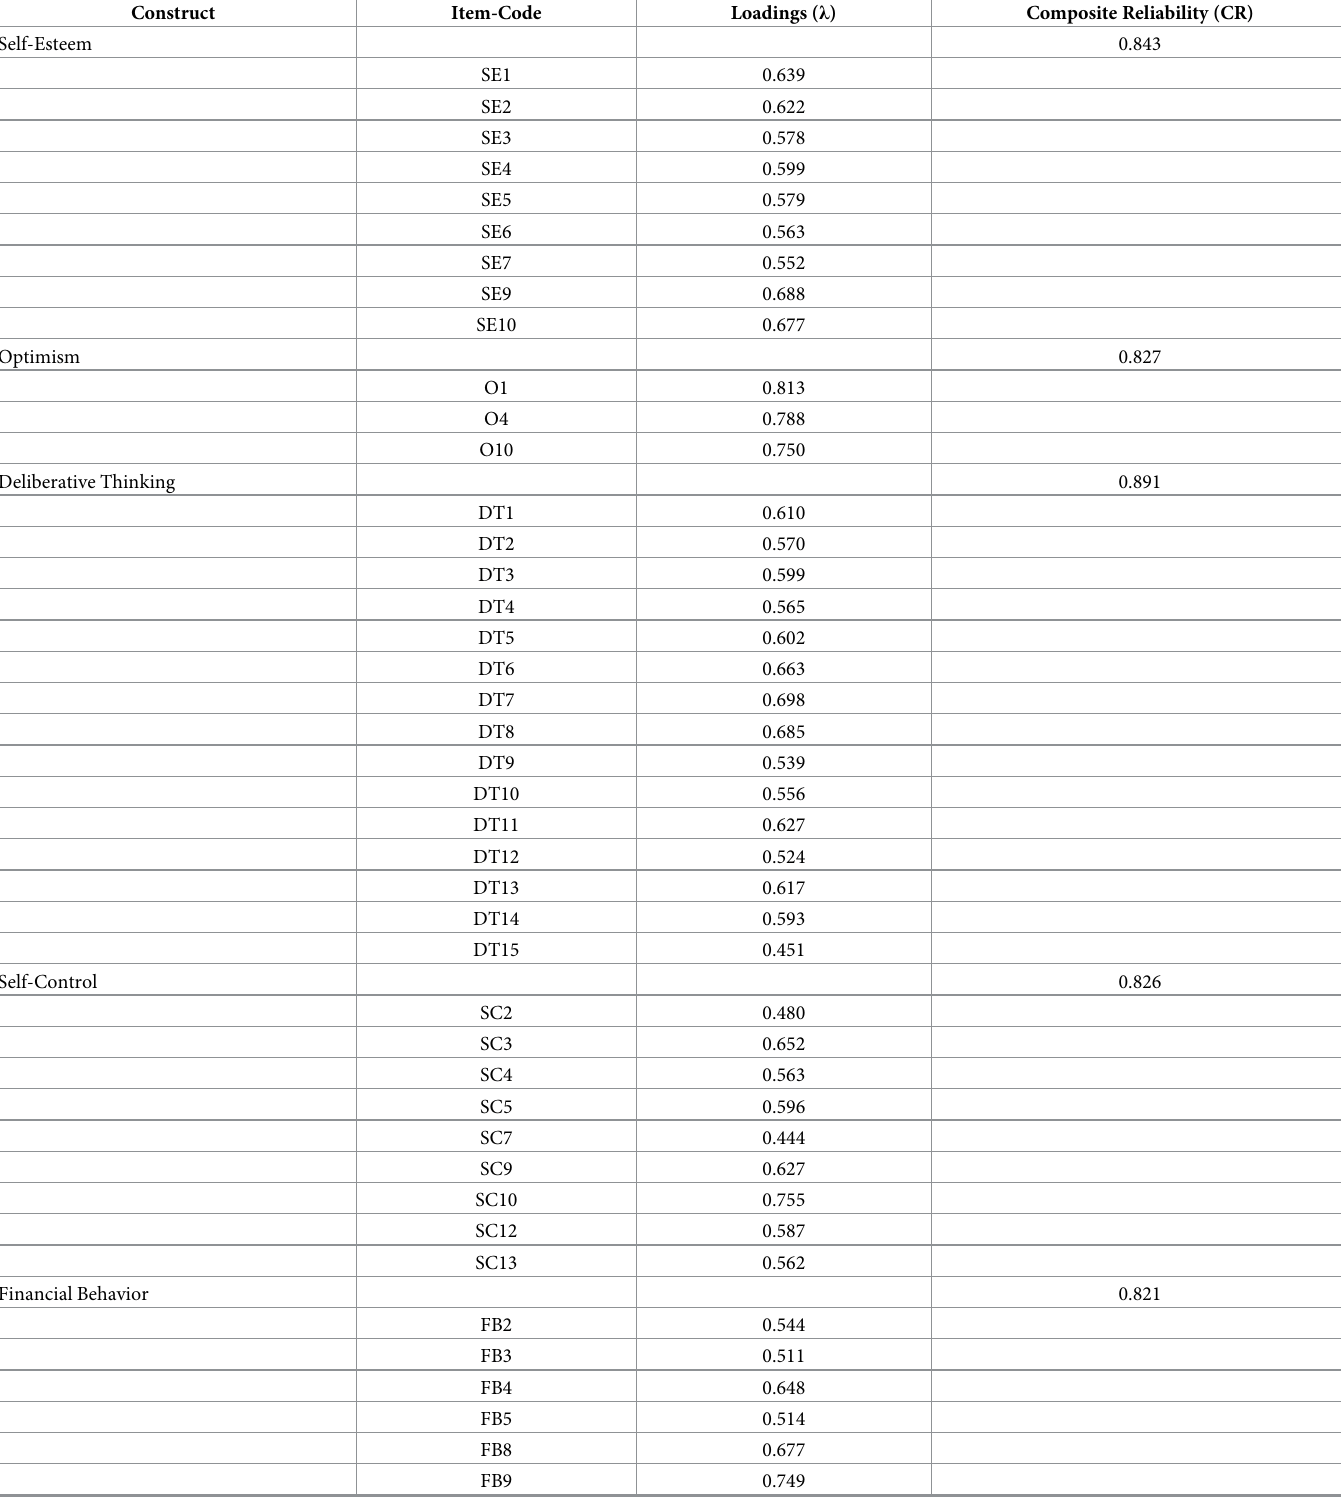
Table 3. Measurement